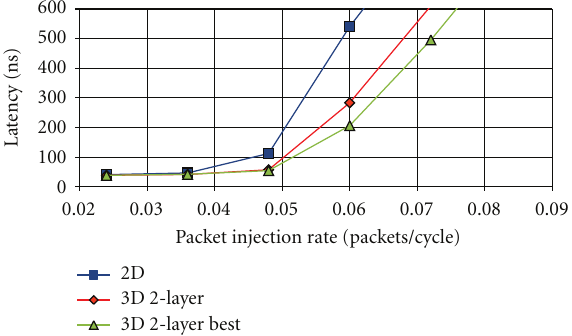
Figure 22: Latency comparison for 2D and 2-layer implementa- tions of ami49